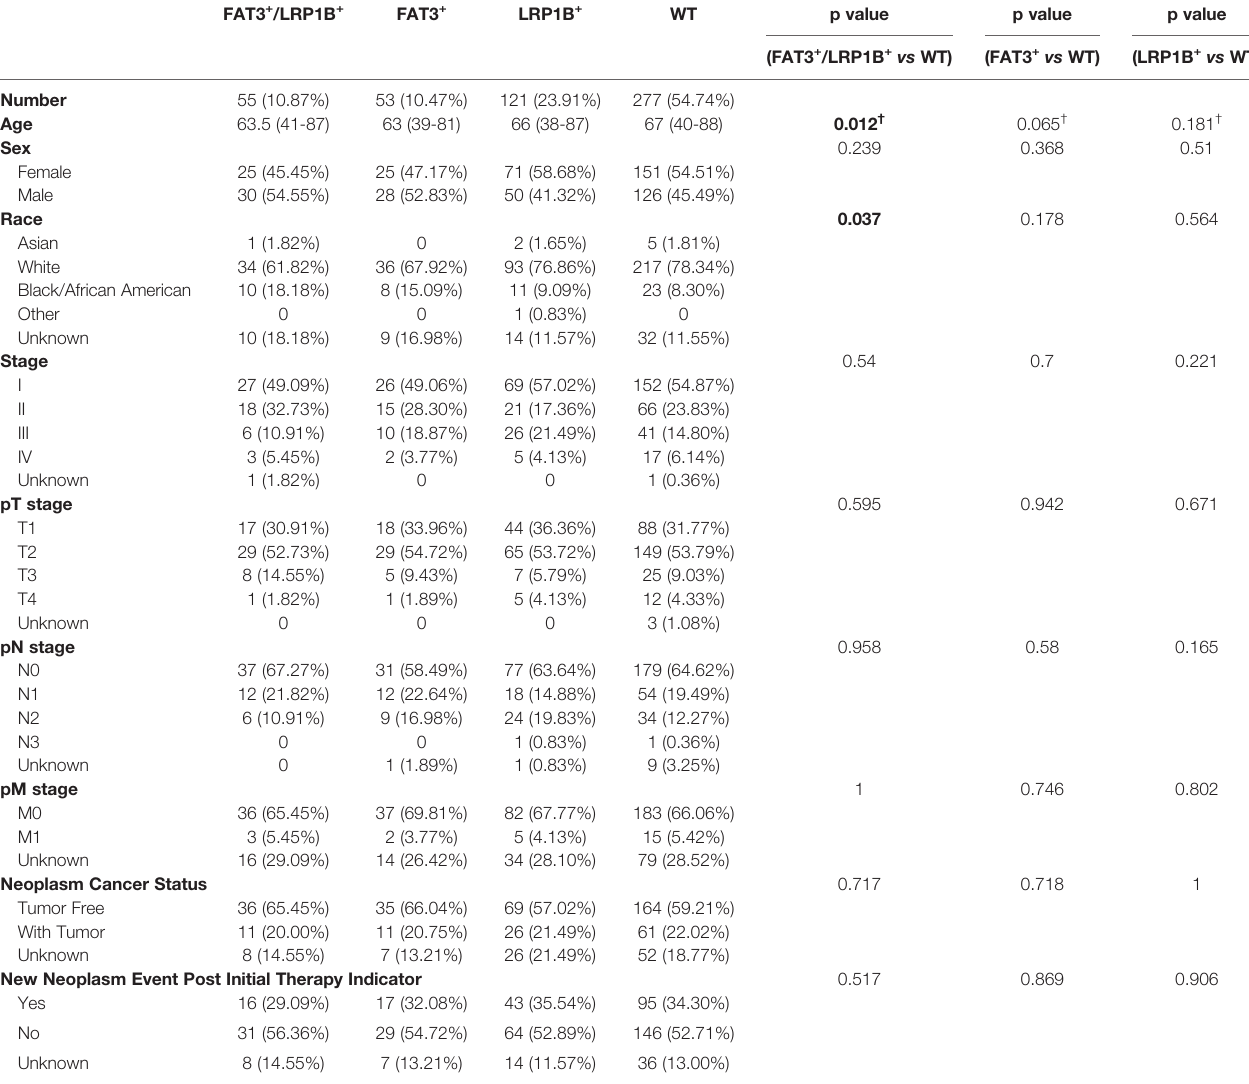
TABLE 1 | Demographic and clinicopathological characteristics in the LUAD cohort according to FAT3 and LRP1B mutation